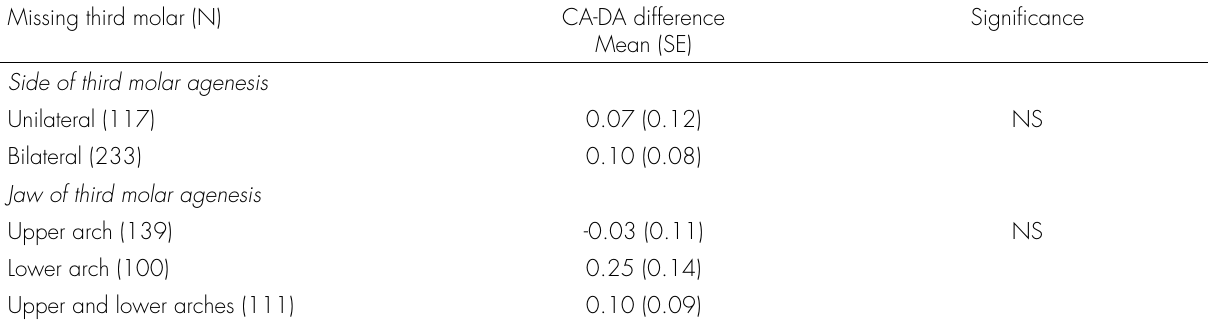
Table III. The means and standard errors (SE) of the difference between chronological and estimated dental ages (CA-DA) according to the severity of third molar